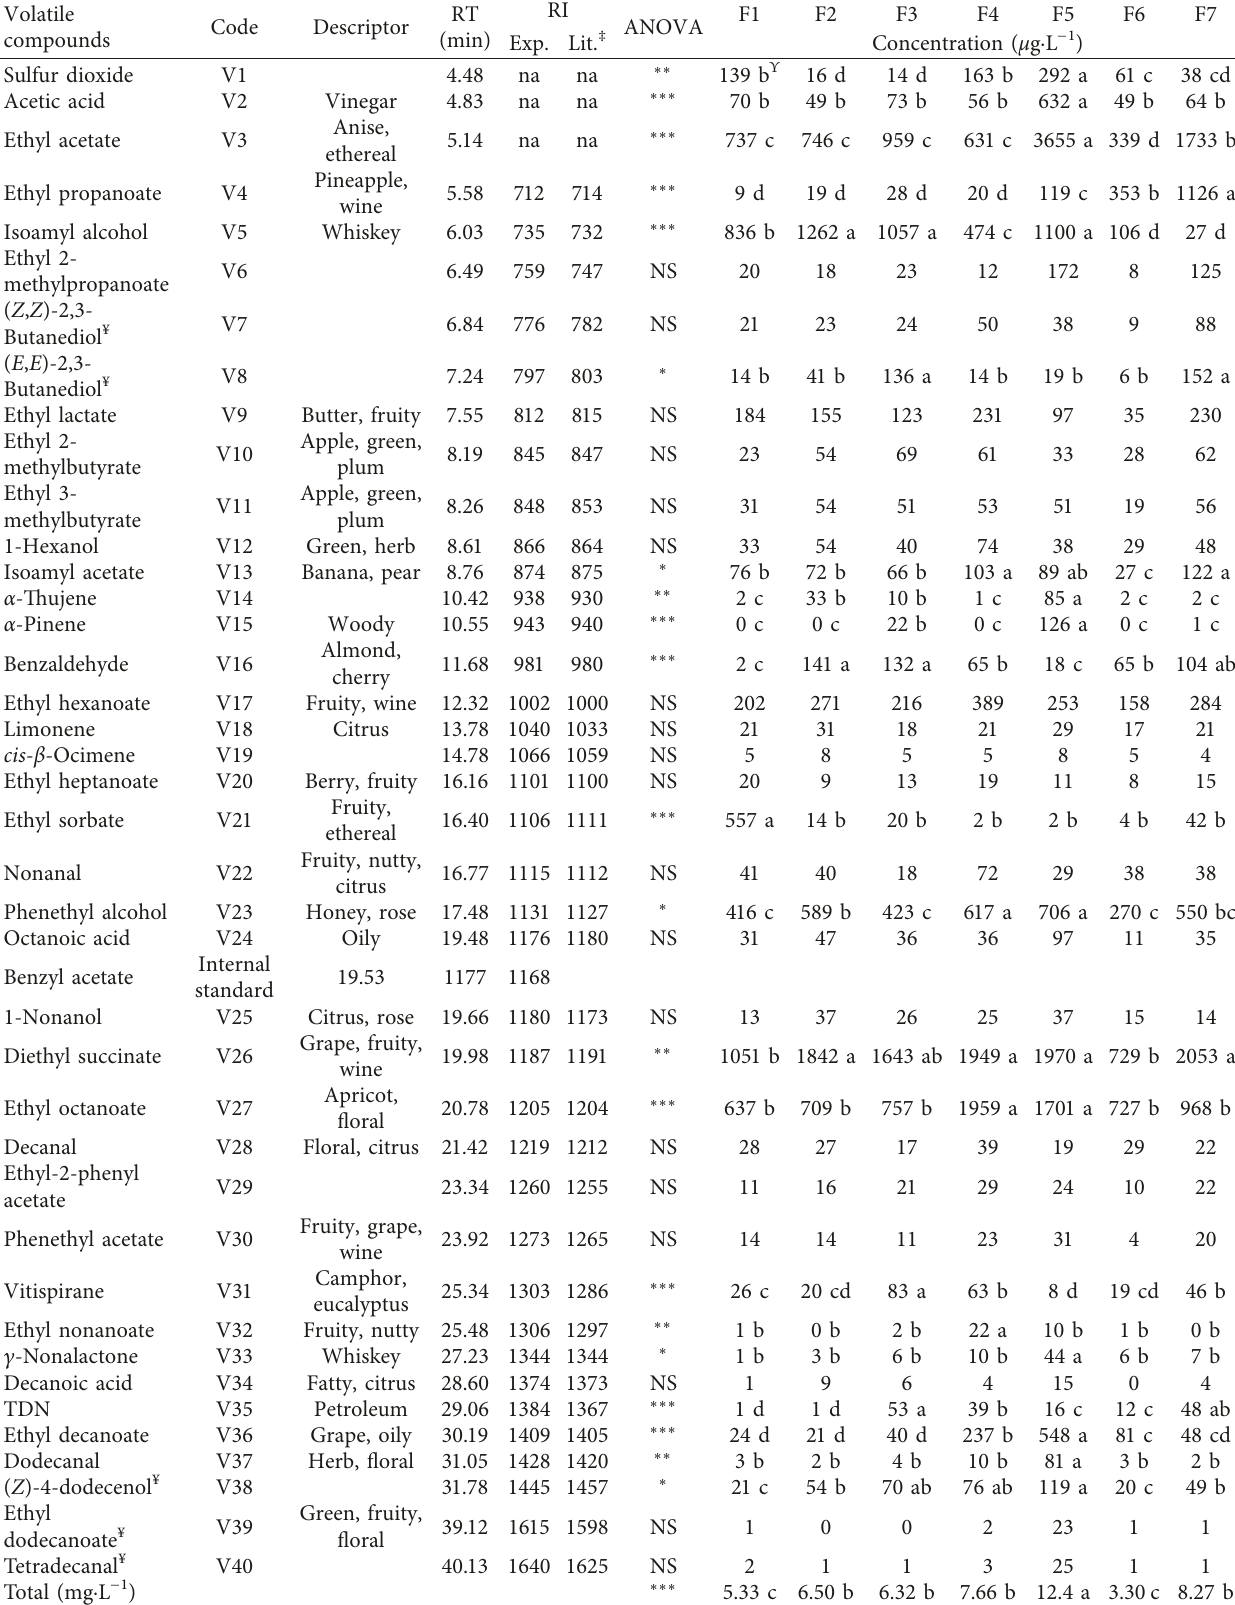
Table 2: Identification and contents ( μ g · L − 1 ) of volatile compounds in Fondill´on